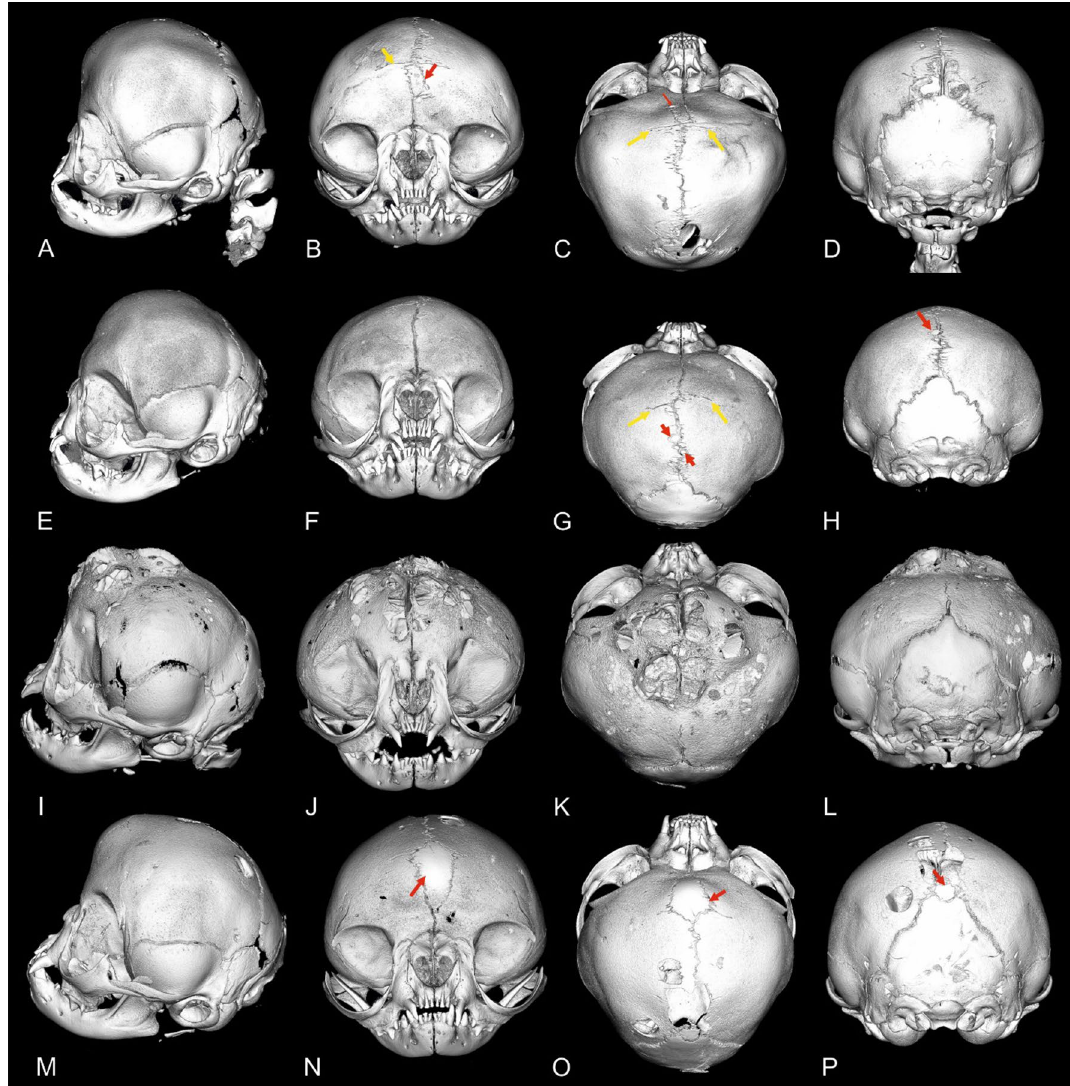
Figure 6. 3D models of a series of skull specimens based on micro-CT images of four peke-face kittens. Red arrows highlight intrasutural ossification centres (Wormian bones). Yellow arrows indicate the remnants of coronal sutures, which are mostly